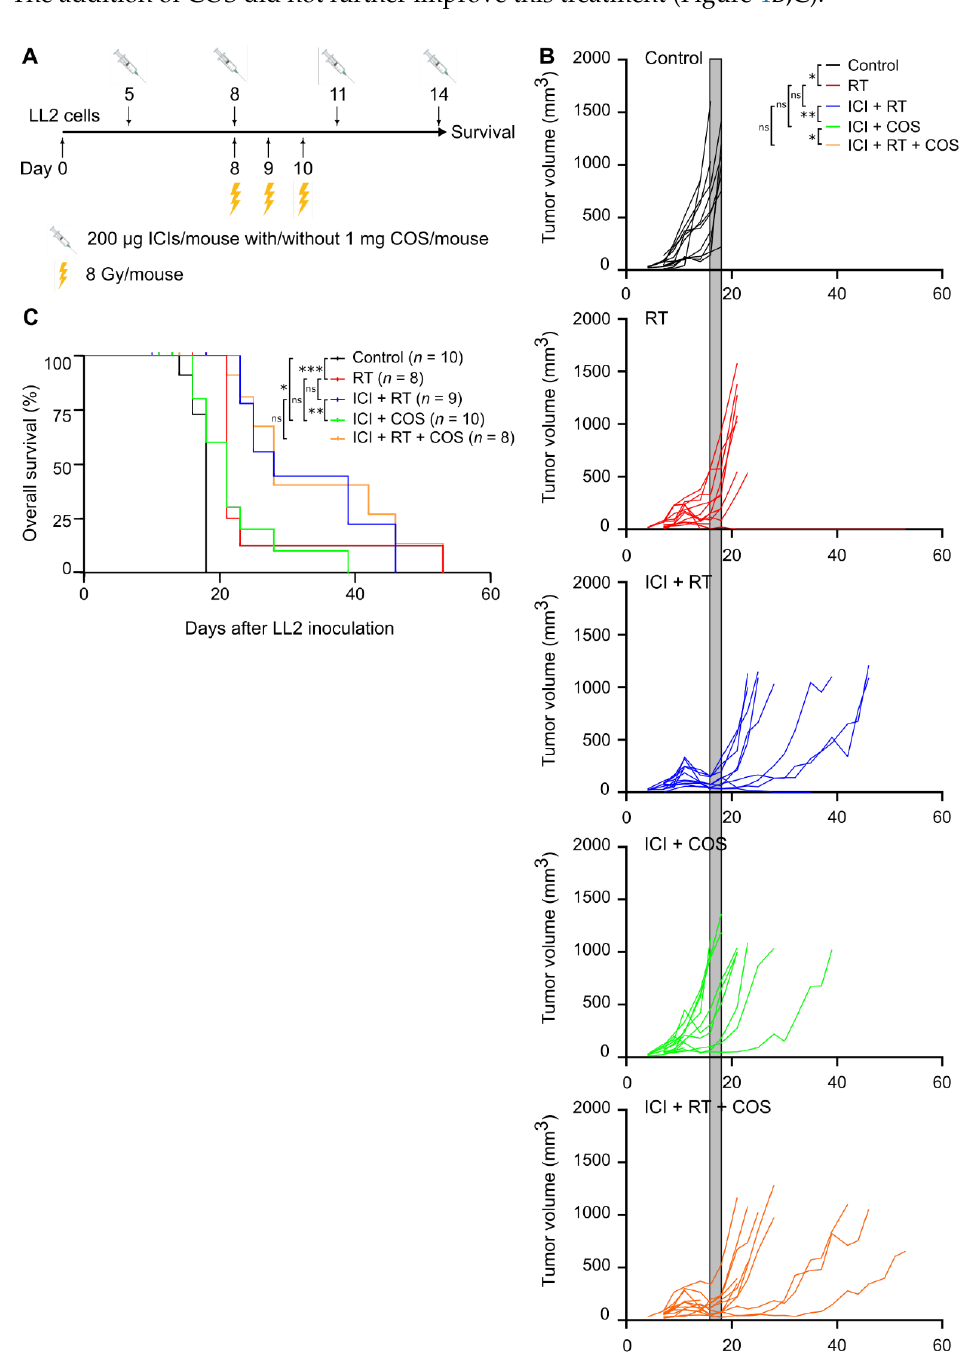
Figure 4. Targeting YKL-40 with COS in combination with ICIs and RT in the LL2 model. ( A ) Treatment regimen and experimental setup of tumor study. ( B ) Individual tumor growth curves for C57BL/6 mice inoculated with 5 × 10 5 LL2 cancer cells ( n = 12 per group). Shaded areas included for easy comparison of the different groups represent the terminal tumor growth time frame of the control group. ( C ) Kaplan–Meier plot of survival curves. * p < 0.05, ** p < 0.01, *** p < 0.001. Abbreviations: COS: chitooligosaccharides; ICI: immune checkpoint inhibitors; ns: not significant; RT: radiotherapy.